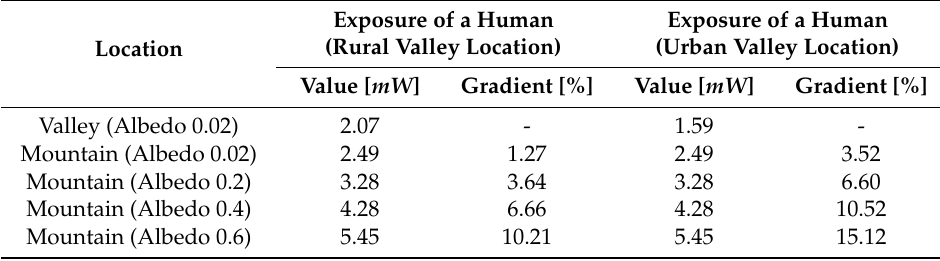
Table 2. Comparison between gradients of rural and urban valley location values to mountain location values as increase in % per 100 m for human exposure. The gradients were calculated with Equation (4), where ∆ altitude = 1600 m was used. Due to the urban aerosol conditions, the urban valley exposure value is lower compared to the rural valley value, resulting in larger gradients in the increase of the human exposure with